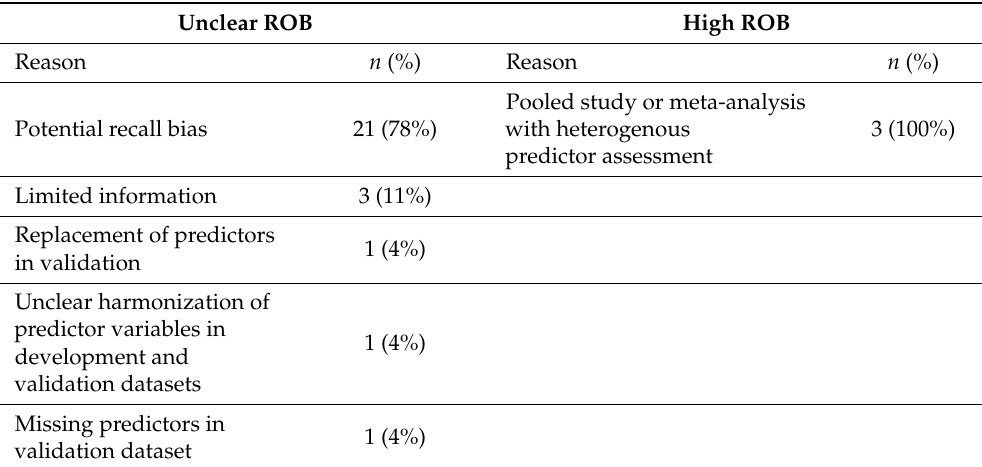
Table 2. Reasons for unclear ( n = 27) and high ( n = 3) ROB ratings in the “predictors”